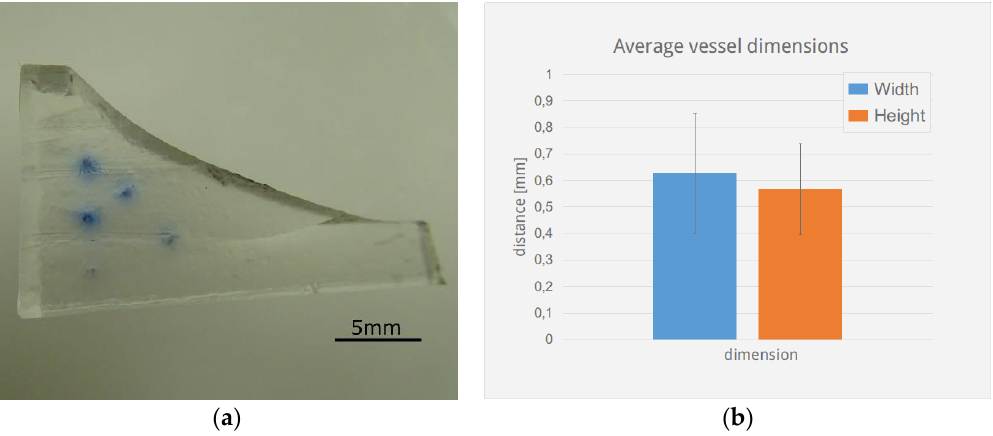
Figure 5. Meniscus channel cross-section. 5 meniscus structures (Figure 3b) were cut perpendicular to the channels and the vessel diameter in the lateral (blue) and vertical directions (orange) were measured under a stereomicroscope with the aid of ImageJ. ( a ) shows a sample section with channel cross-sections and stains from the diffused ink. ( b ) shows a bar-chart with average values and standard deviation. To increase the stability of the fabricated structures additional cross-linking would be an option.